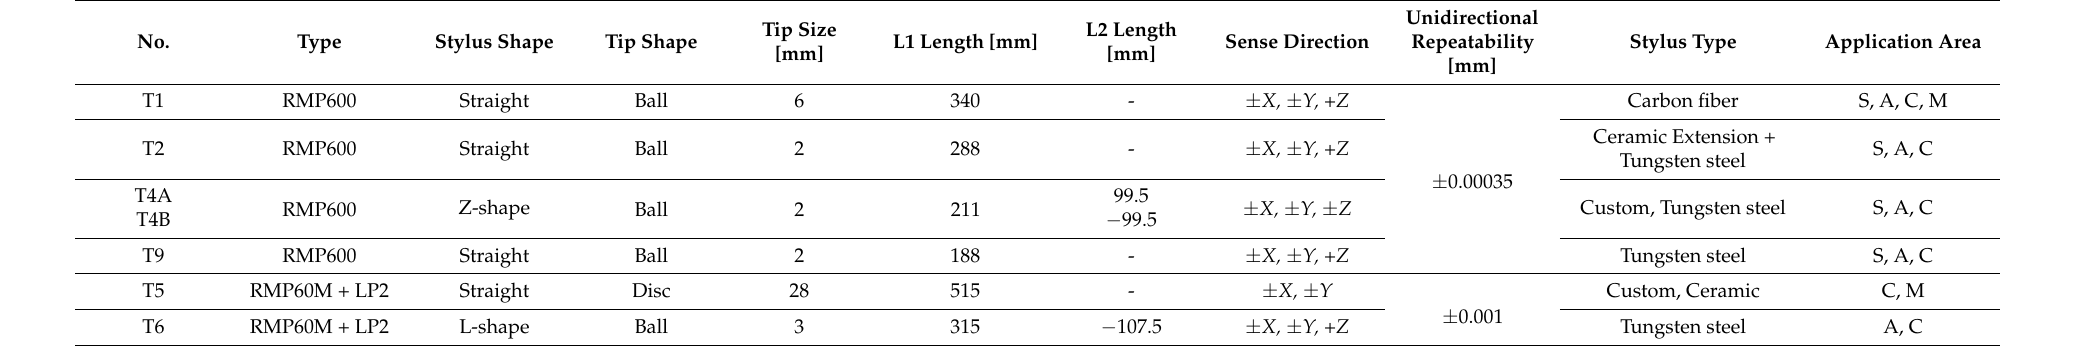
Table 2. Touch-trigger probe configuration included in an advanced on-machine measurement system [34]. Application tags: S, setup; A, process adaptive; C, measurement; M, machine tool checkup and